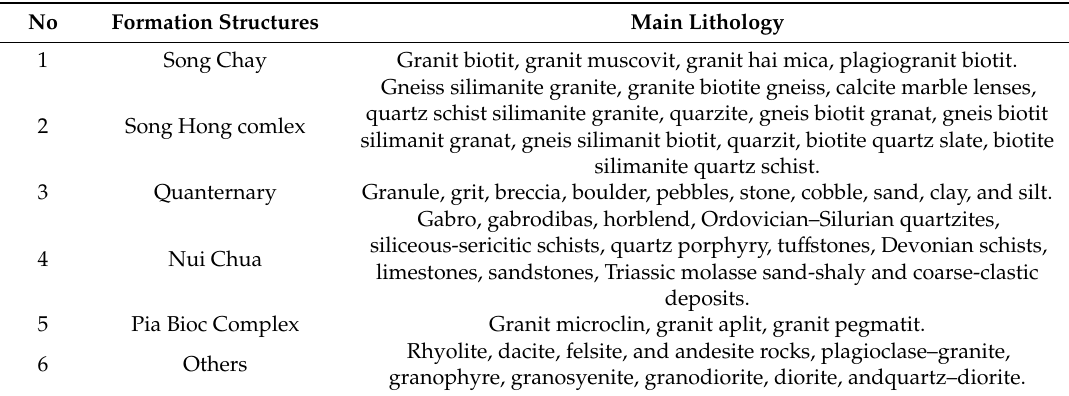
Table 2. Characteristics of the lithological formations in this study